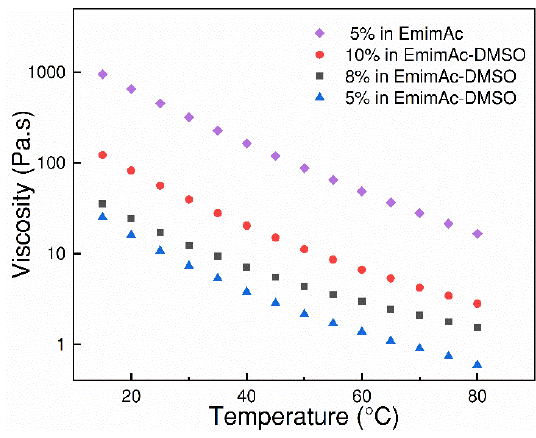
Figure 3. The viscosities of different cellulose/ionic liquid (IL) solutions as a function of temperature.